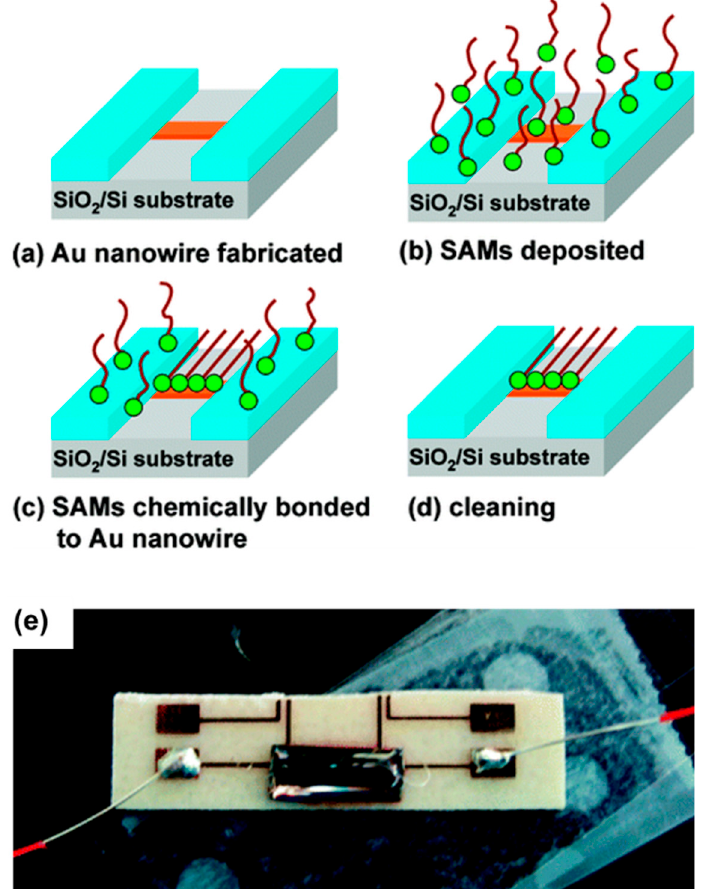
Figure 20. The process of detecting the concentration of octadecanethiol molecular solution using a single Au nanowire: ( a ) Au nanowire was fabricated on the silicon / silicon dioxide substrate, ( b ) self-assembled monolayers (SAMs) were deposited on the silicon / silicon dioxide substrate with Au nanowire, ( c ) SAMs chemically bonded to Au nanowire, ( d ) other SAMs not bonding to the Au nanowire was cleaned and ( e ) top-view photograph of a resistance measurement unit using Au nanowire [53] .